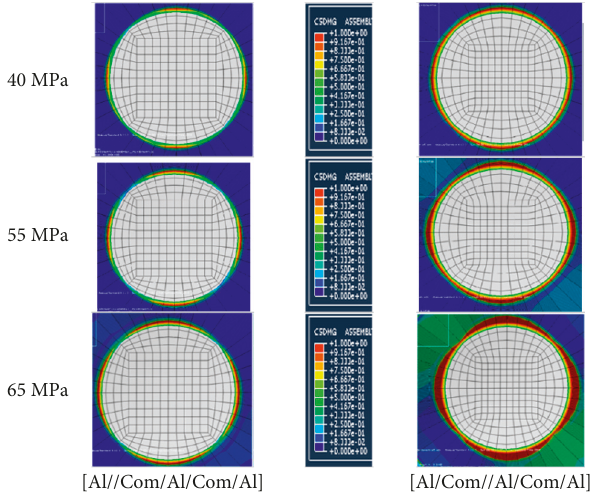
Figure 14: Contour plots of delamination growth of GLARE 3-3/2- 0.5 in different shear load Figure 11 indicates that GLARE 3-3/2-0.4 with internal